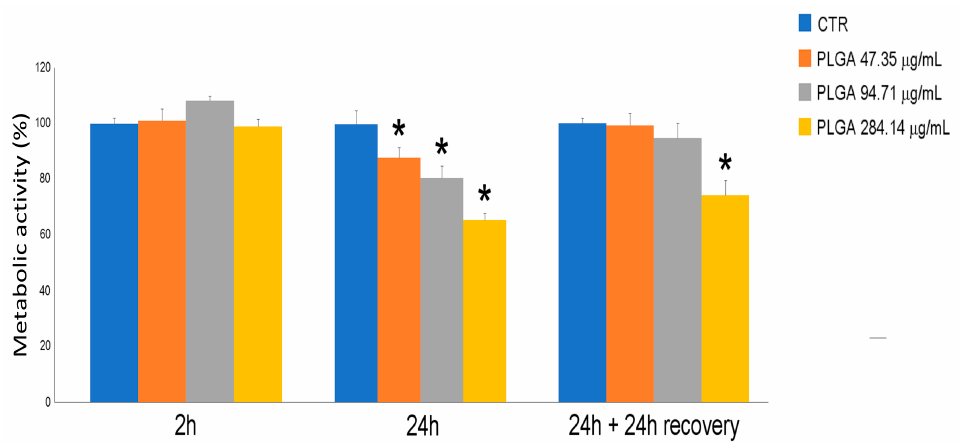
Figure 3. C2C12 myoblast metabolic activity, evaluated by MTT assay after 2 h, 24 h, 24 h + 24 h recovery treatment, in presence of 5% SC-nanoparticles. Data are given as mean values ± SEM, representative of three independent experiments. * p < 0.03 vs. control (CTR) sample.